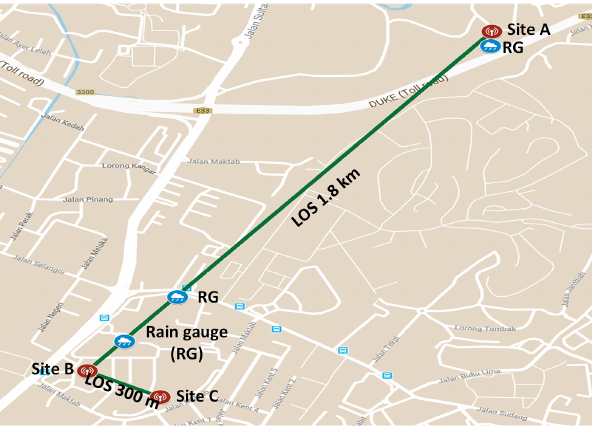
Figure 1. Measurement links map in Kuala Lumpur, Malaysia for 1.8-km and 300-m line-of-sight (LOS) path at 73.5 and 83.5 GHz E-bands between Kolej Siswa Jaya (Site A) and Menara Razak, Universiti Teknologi Malaysia (Site B); and 300-m LOS path at E-band between Site B and Residensi UTM (Site